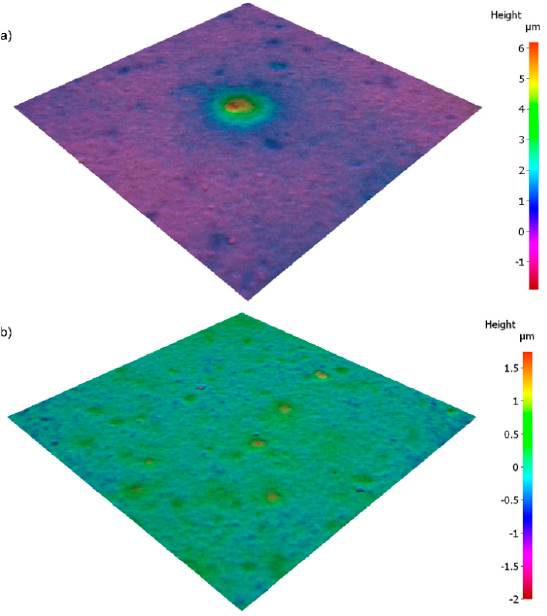
Figure 4. Infinite focus micrographs for ( a ) epoxy coating containing microcapsules, and ( b ) epoxy coating with no microcapsules.